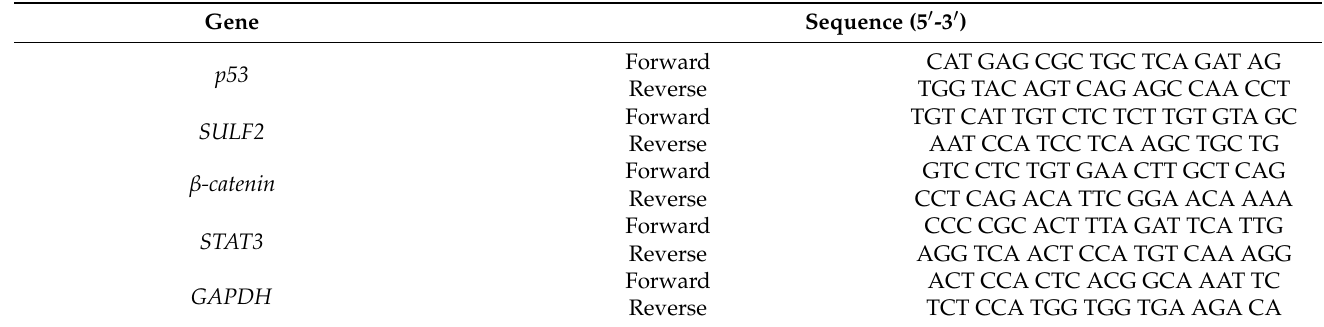
Table 1. Primer sequences used for